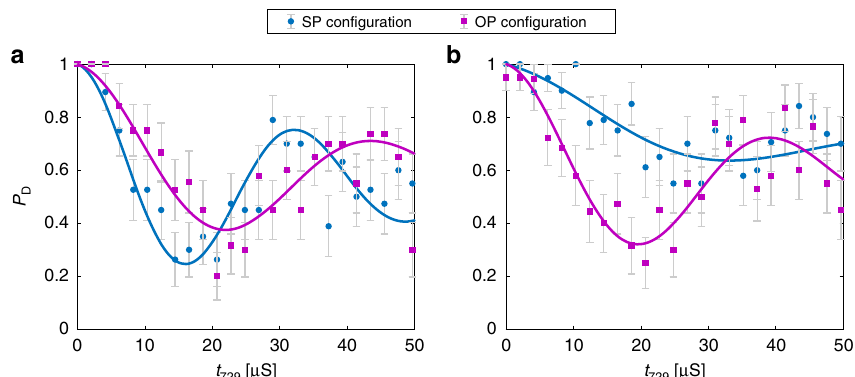
Fig. 3 Rabi thermometry. Rabi oscillation signals for the SP (blue) and OP (purple) lattice con fi gurations after an ODF pulse for two different molecular states (panels a and b ). Each data point is an average of 20 ODF excitations. Error bars represent 1 σ binomial uncertainties. The solid curves represent fi ts to the data as described in the Methods section from which the ac-Stark shifts were extracted. a The stronger SP signal (larger frequency and amplitude of the Rabi oscillation) suggest that the lattice laser ( λ = 789.71 nm, in both experiments) was red detuned from the closest molecular transition. By comparing the measured amplitude and sign of the ac-Stark shift with theory (Methods), the molecular state could unambiguously be be identi fi ed as N ″ = 6, J ″ = 11/2. b The stronger OP signal suggests that the lattice laser was blue detuned from the closest molecular transition. Therefore, all rotational states N ″ ≤ 4 can be excluded (see below).